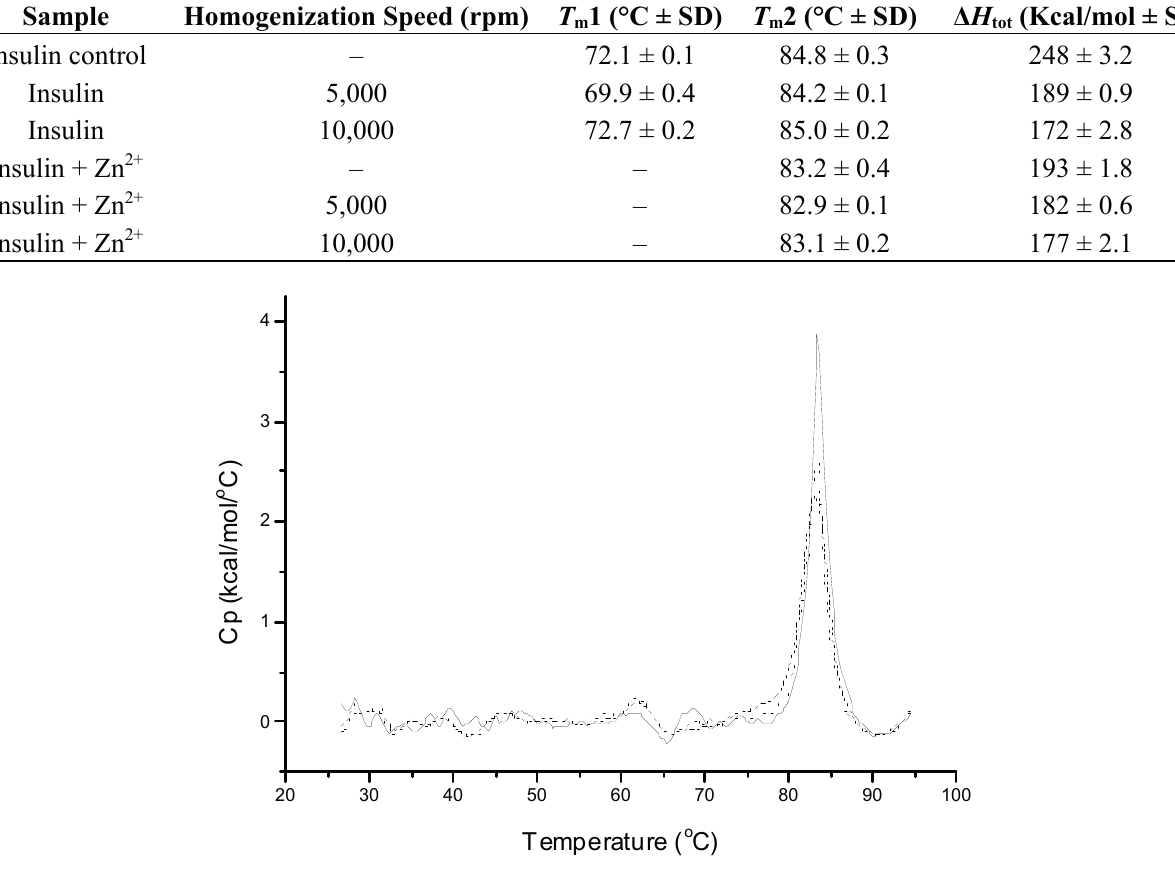
Figure 2. DSC thermograms of 0.6 mM insulin with 0.3 mM zinc acetate in phosphate buffer (pH 7.4, 10 mM) and insulin extracted after homogenization. Full line, native insulin solution with zinc; dotted line, insulin extracted after homogenization at 5000 rpm; and dashed line, insulin extracted after homogenization at 10,000